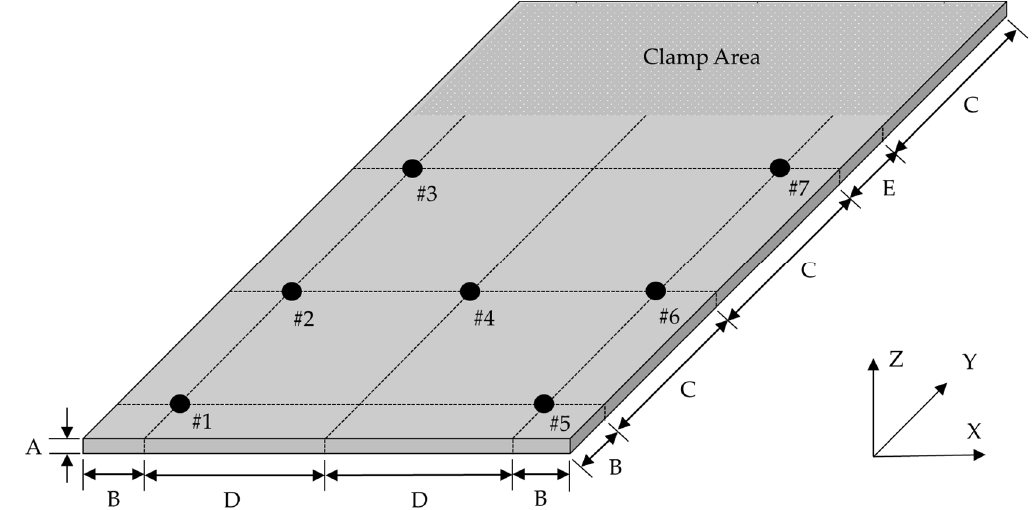
Figure 2. Clamping area and sensor attachment locations of simple CFRP specimen. A: 3 mm; B: 10 mm; C: 40 mm; D: 30 mm; E: 20 mm.